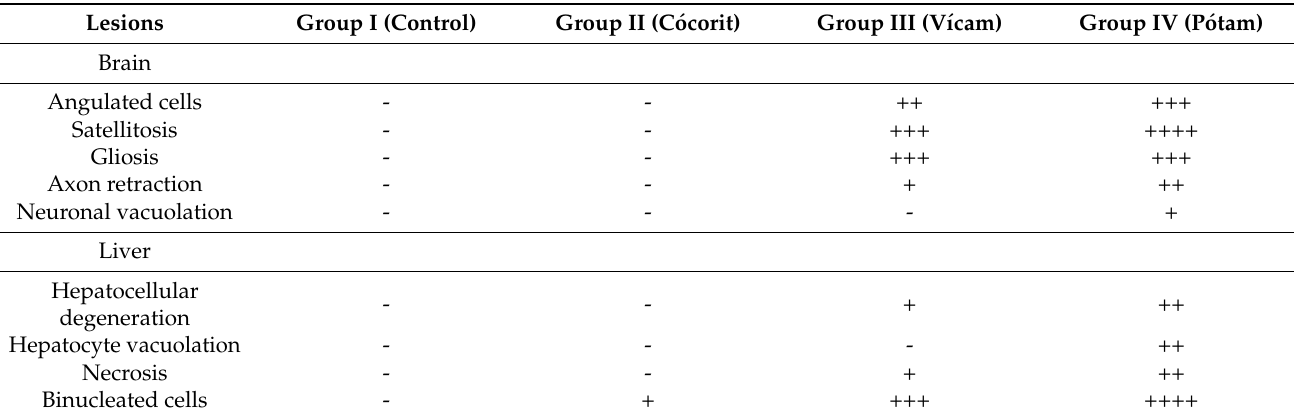
Table 2. Histopathological grading of liver and brain following exposure to low concentrations of arsenic in water. Here, N = 5. -, nil; +, minimal (<15%); ++, mild (<25%); +++, moderate (<45%) and ++++, severe (>45%).